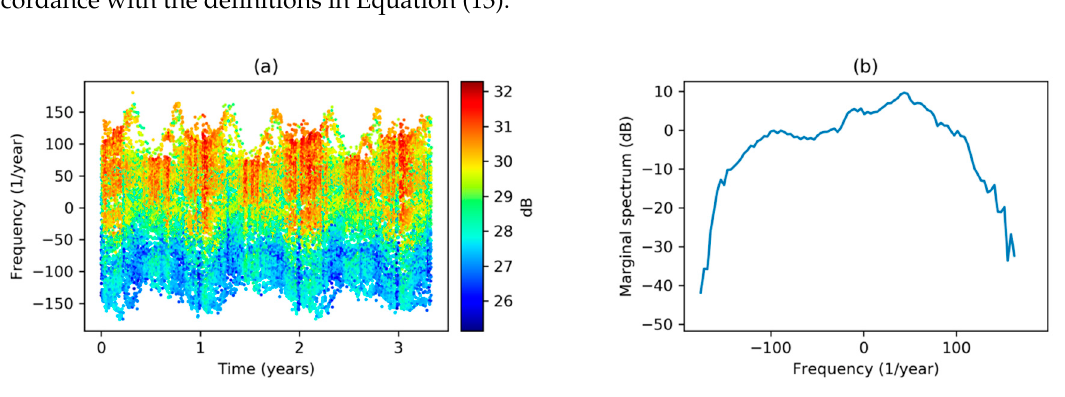
Figure 7. Empirical Mode Decomposition of the electricity demand: Monthly scale. For a better understanding of the IMFs behavior, they are also represented in a weekly timescale. Figure 8 depicts a 10-week sequence corresponding to the time-domain representation of